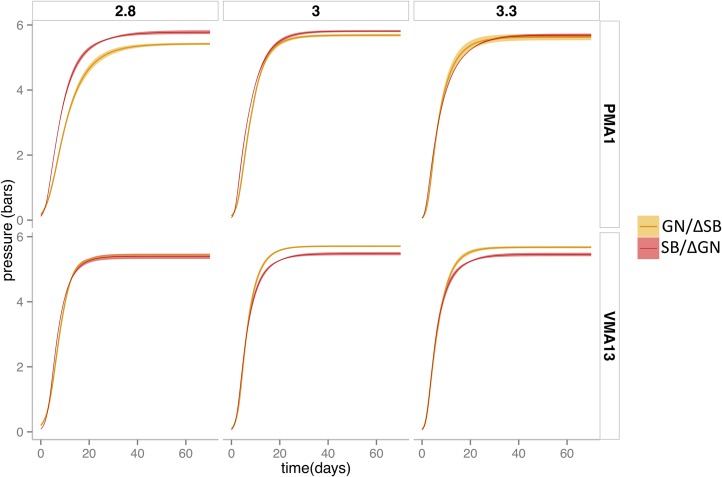
Kinetic curves of the hemizygotes for PMA1 and VMA13, and the diploid hybrid strain BN obtained when fermenting base wine at different pH: 2.8, 3.0, and 3.3. The kinetic curve is the mean between triplicates and the shadow around the line represents the SE.